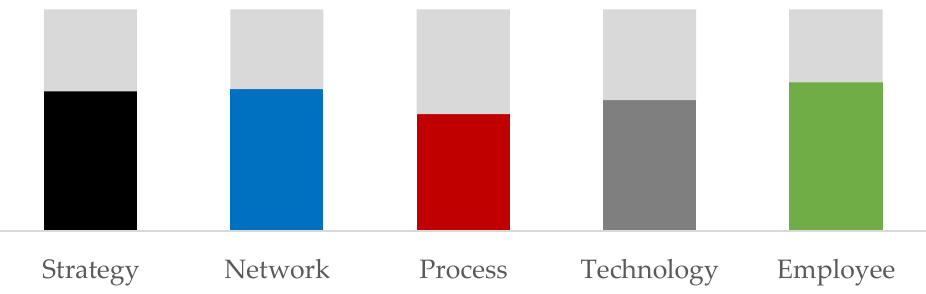
Figure 12. Level of the five logistics dimensions for the advanced profile.